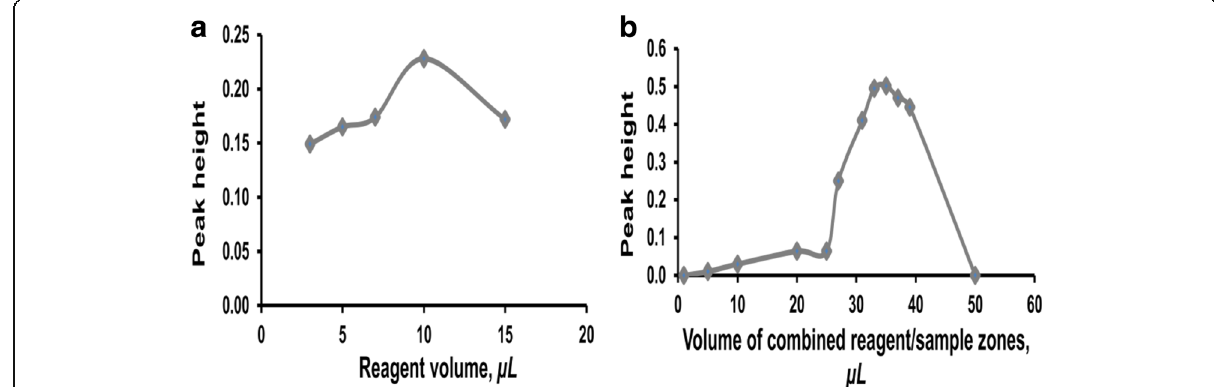
Fig. 2 a Variation of reagent volume in search of the optimum using 40 μ L of a 2.0 mg N L − 1 standard. b Profile of zone penetration in a two-zone stack in the optimization of dispensed volume